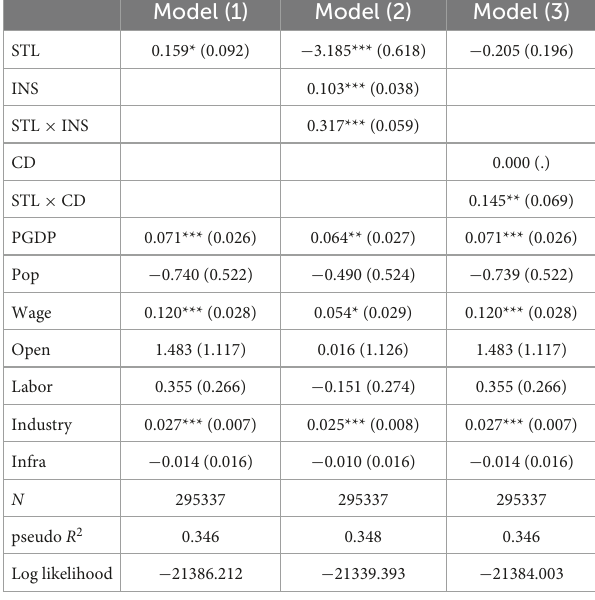
TABLE 4 Regression results for replacing the foreign firm definition